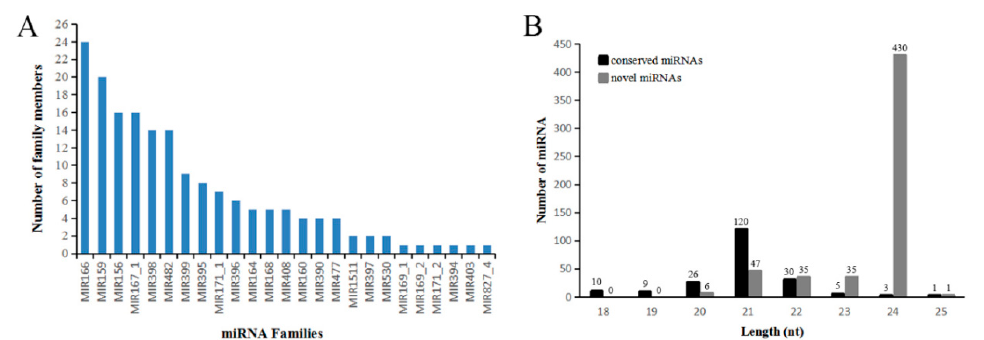
Figure 5. miRNAs identified from walnut kernels. ( A ) Families and members distribution of known miRNA. ( B ) Length distribution of known miRNA and novel miRNA.